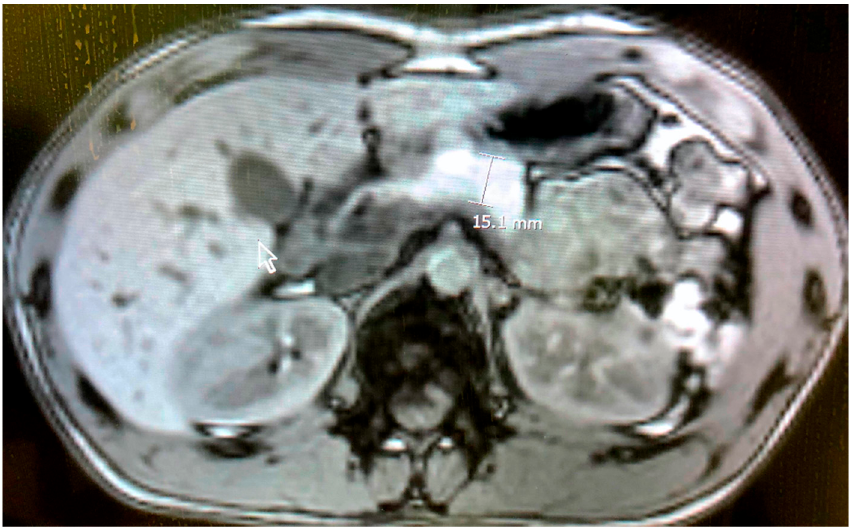
Figure 2. Normalization of abdominal magnetic resonance imaging of the pancreatic gland after treatment.